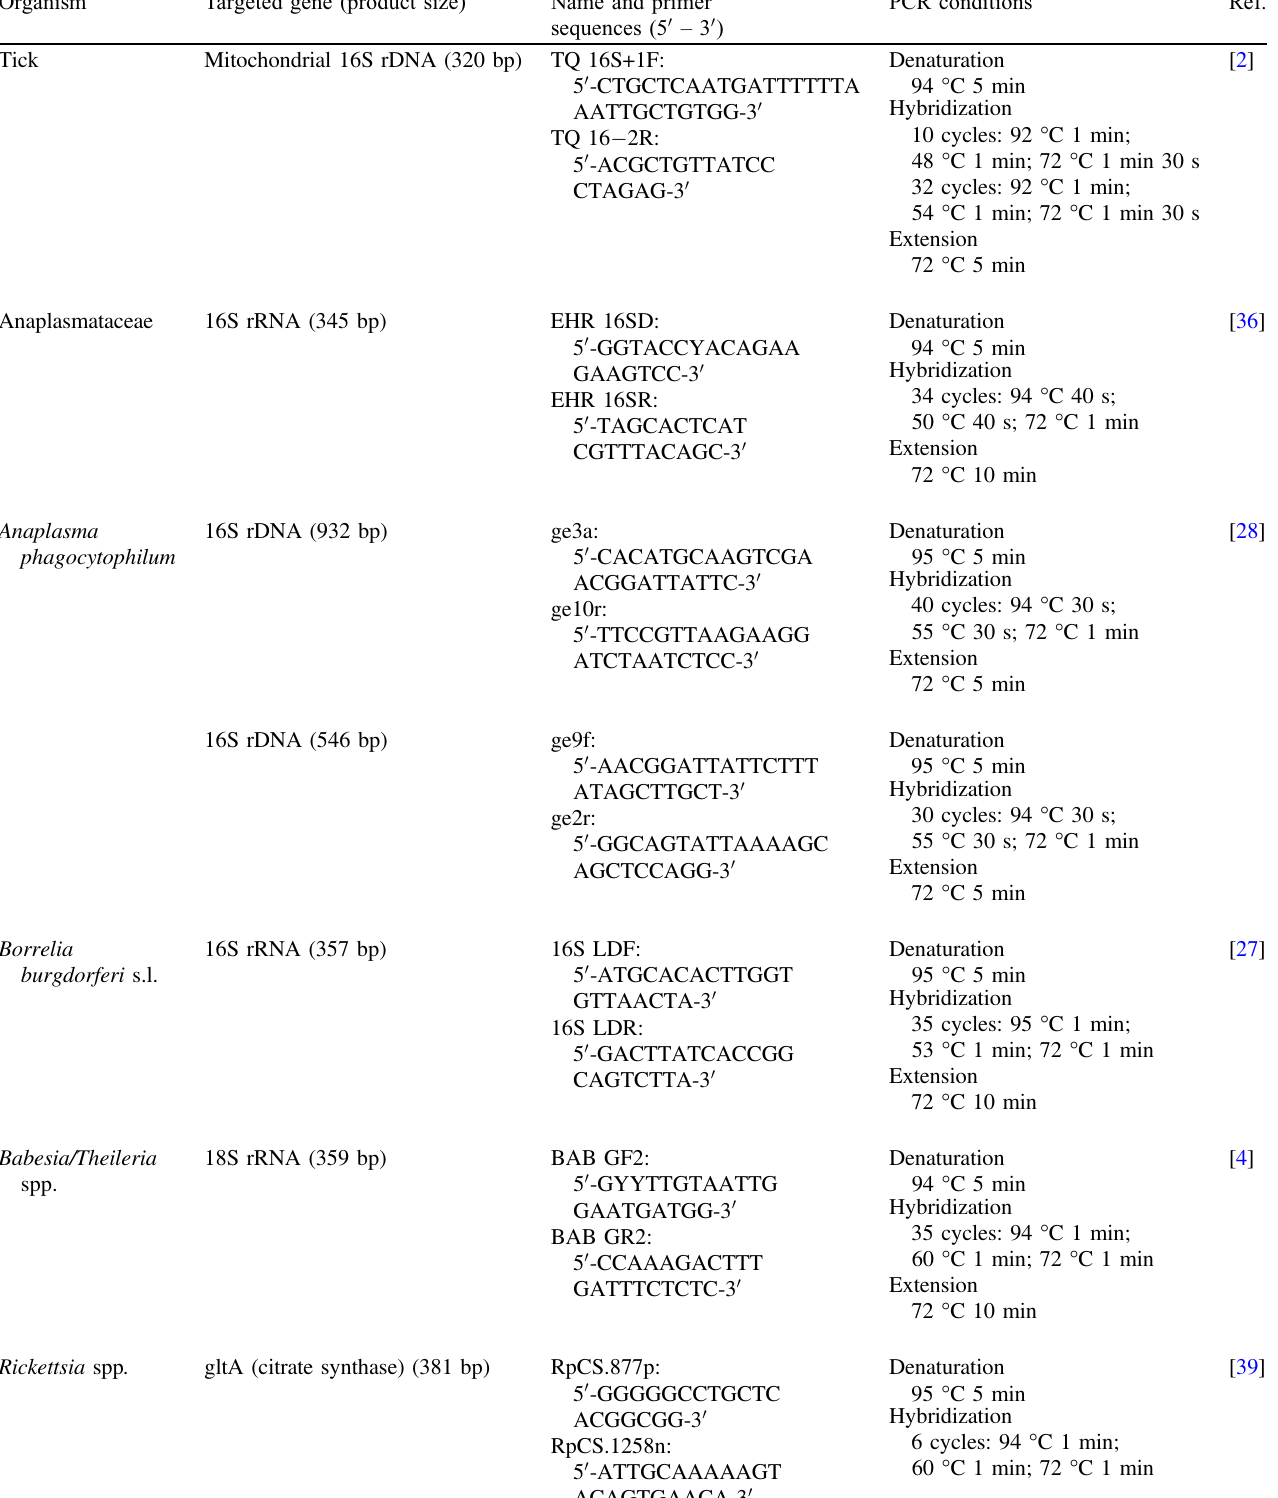
Table 1. Primers used in the PCR assays conducted in this study with their respective references.